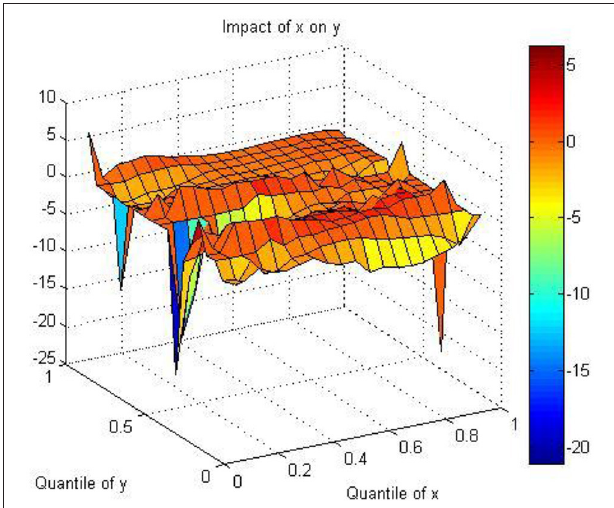
FIGURE 1 | THe estimation of the slope coefficient three-dimensional diagram. X indicates healthcare expenditure; Y indicates economic